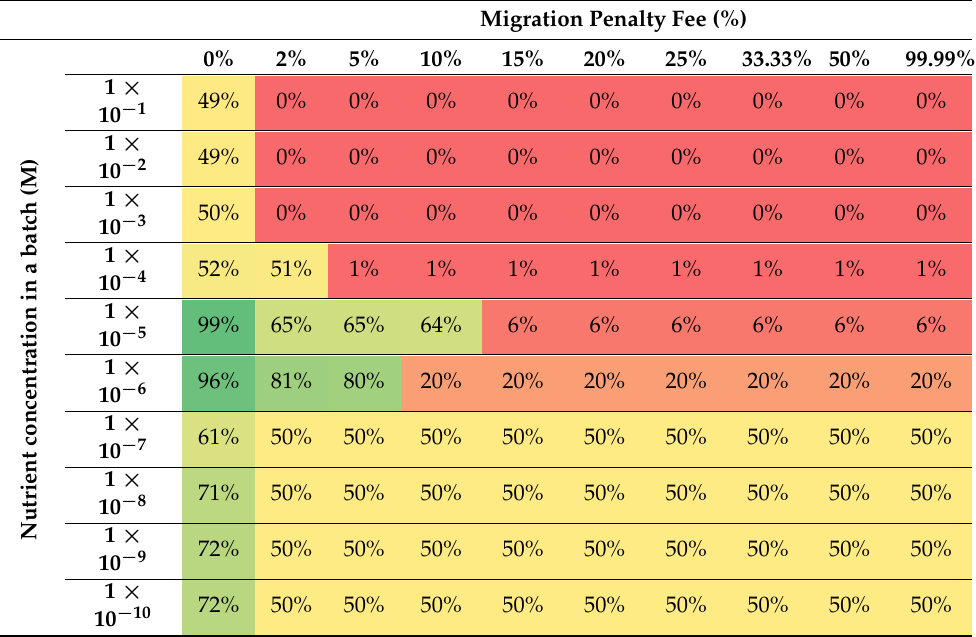
Table 4. Nomad’s abundance fraction against migration penalty fee in the environments varying by nutrient concentration in a batch from “extremely scarce” to the “rich” ones. The batch period equals to 50 generations. The linear mortality term is